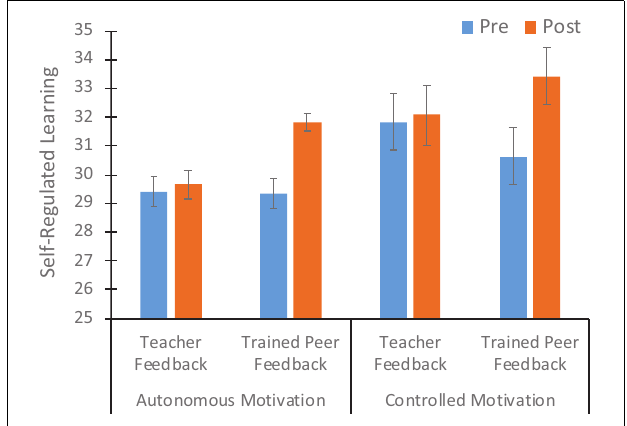
FIGURE 1 | Mean (with SE bars) pretest and posttest self-regulated learning scores by